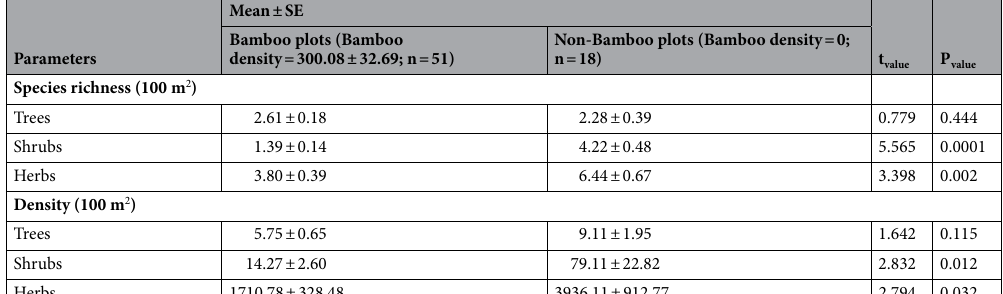
Non-Bamboo plots (Bamboo density = 0; n = 18)